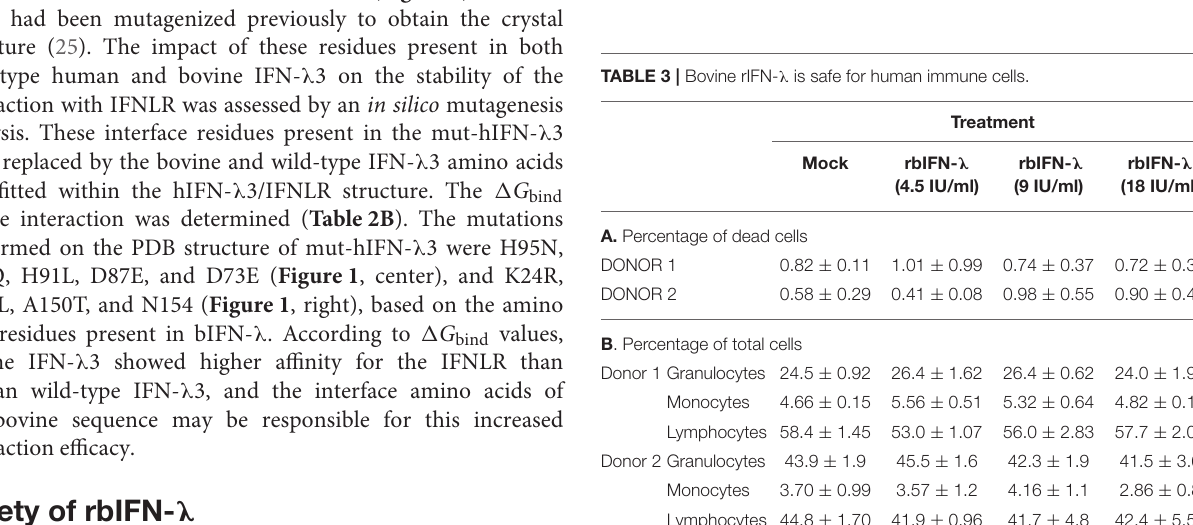
Frontiers in Veterinary Science |